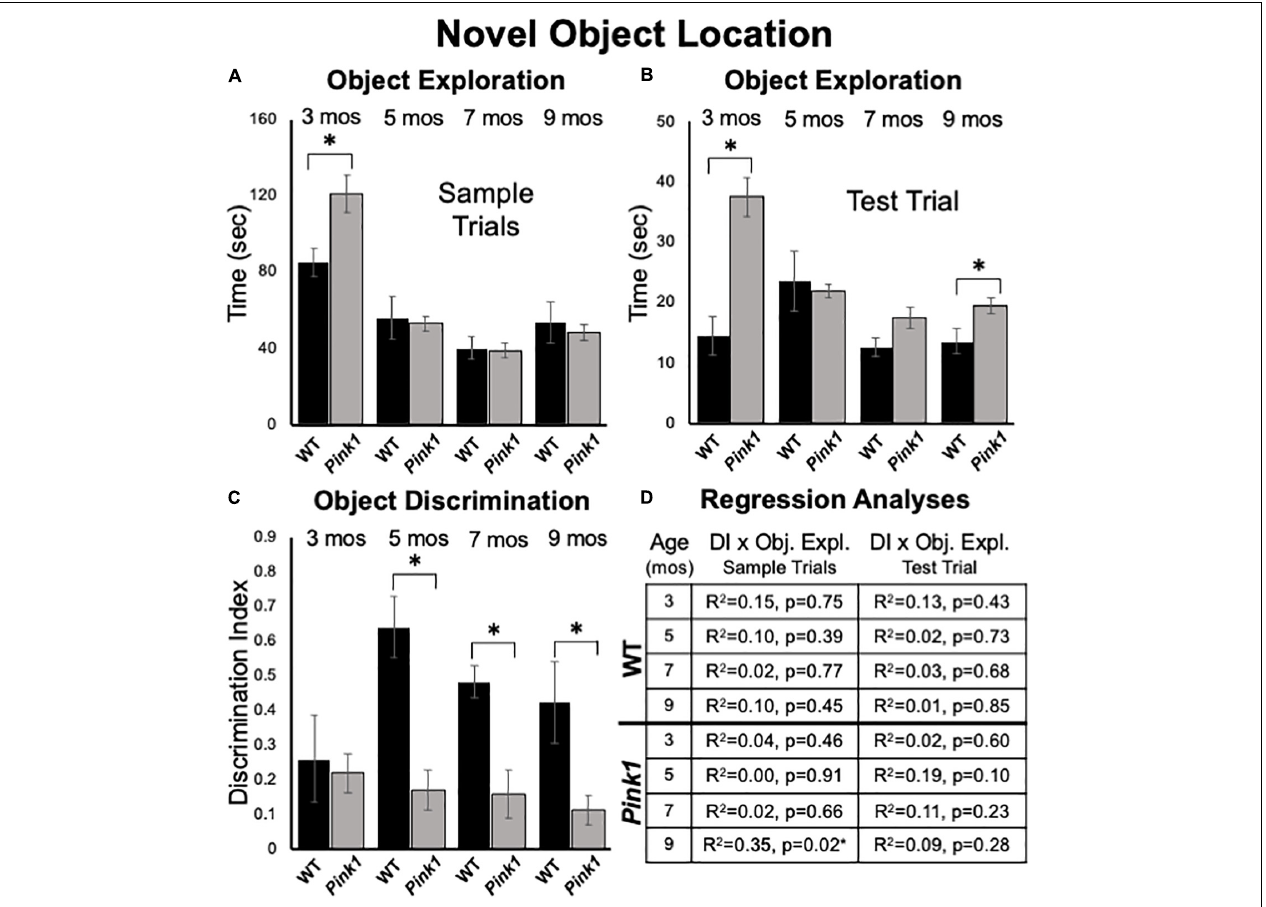
FIGURE 6 | Novel Object Location data. Bar graphs showing total times in seconds (sec) that wild type (WT, black bars) and rats with knockout of the PTEN (phosphatase and tensin homolog)-induced putative kinase1 gene ( Pink1–/–, gray bars) spent actively exploring objects during Sample Trials (A) and during Test Trials (B) in testing at 3, 5, 7, and 9 months (mos) of age. In general, Pink1 –/– rats spent equal or more time than WT rats investigating objects; asterisks identify object exploration times as significantly greater in the Pink1 –/– compared to WT cohort for testing at 3 mos of age during Sample Trials (A) , and for testing at 3 and 9 mos of age during Test Trials (B) . (C) Bar graphs showing calculated discrimination index (DI) for WT (black bars) and Pink1 –/– rats (gray bars). This measure of object location memory was similar in rats of both genotypes at 3 months of age. At all other ages, DIs were significantly greater ( ∗ ) in WT than in Pink1 –/– rats. (D) Tables showing R 2 and p -values for regression analyses comparing DIs to total sample object exploration times and to test trial object exploration times in WT and Pink1 –/– rats at each age tested. No significant or near significant positive correlations were found among these measures. However, a significant negative correlation ( ∗ ) between increased sample trial object exploration and lower DI values was found for Pink1 –/– rats at 9 months of